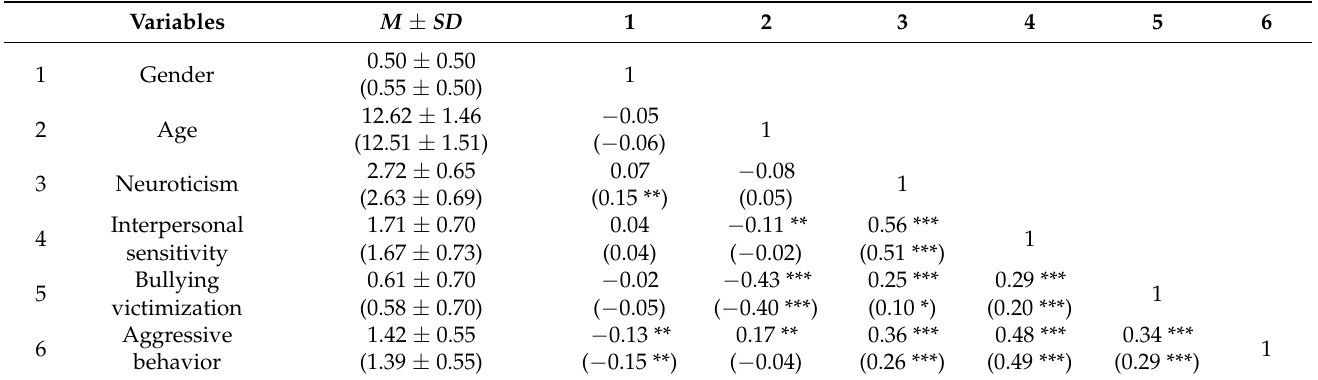
Table 1. Descriptive statistics and correlations between variables ( n =